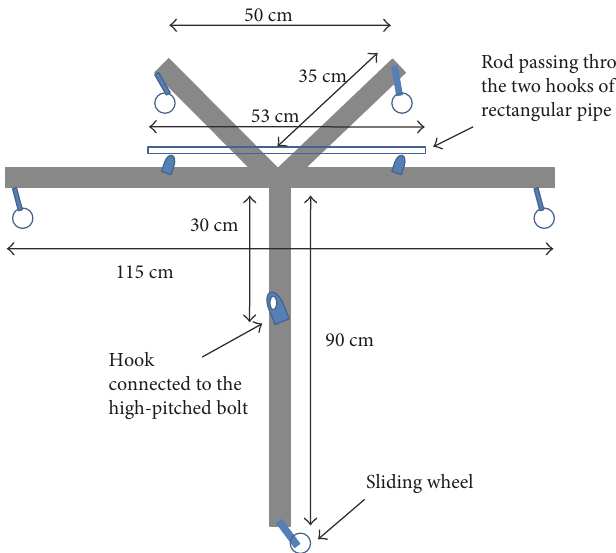
Figure 5: Schematic diagram of the Y-shaped support frame, placed on a level surface.